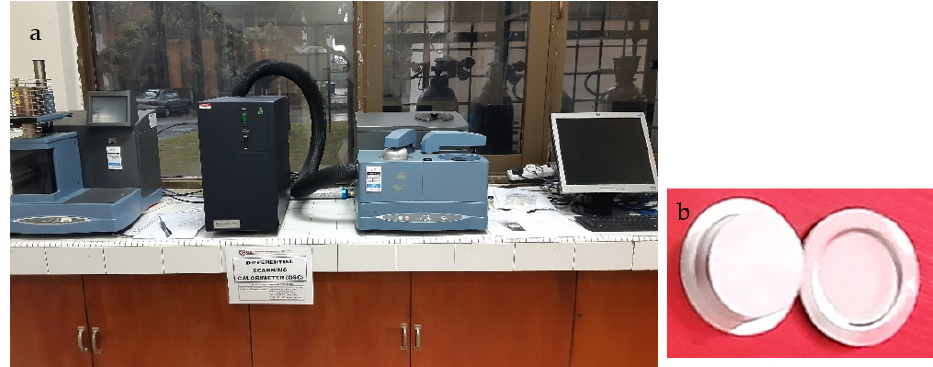
Figure 4. ( a ) Differential Scanning Calorimeter (DSC) and ( b ) aluminum sample pan (5 mm).